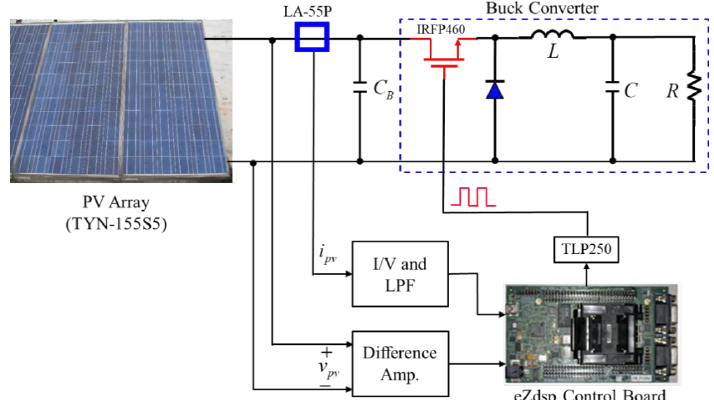
Figure 15. The basic configuration of the PV system.